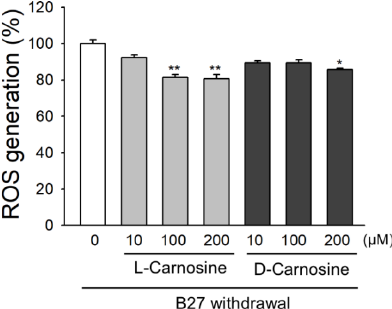
Figure 3. L- and D-carnosine reduce ROS accumulation in primary mouse neurons following 24 h B27 withdrawal. Neurons were loaded with H2DCFDA (20 µM) and oxidative stress induced by the removal of B27 supplement. Values expressed as a percentage relative to control condition (no